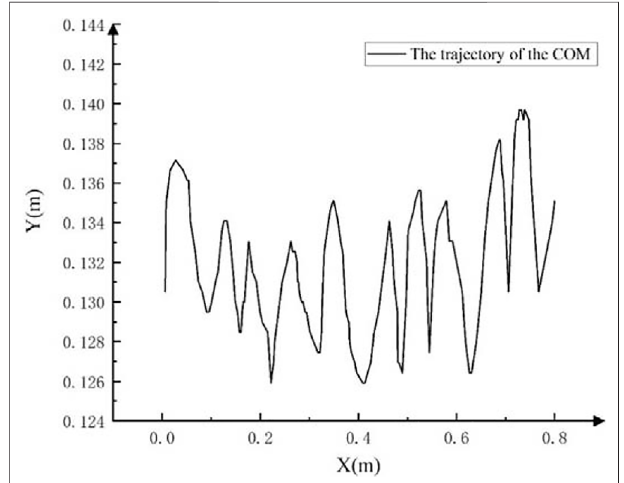
FIGURE 15 | The straight walking trajectory of the center of mass of the robot on the fl at